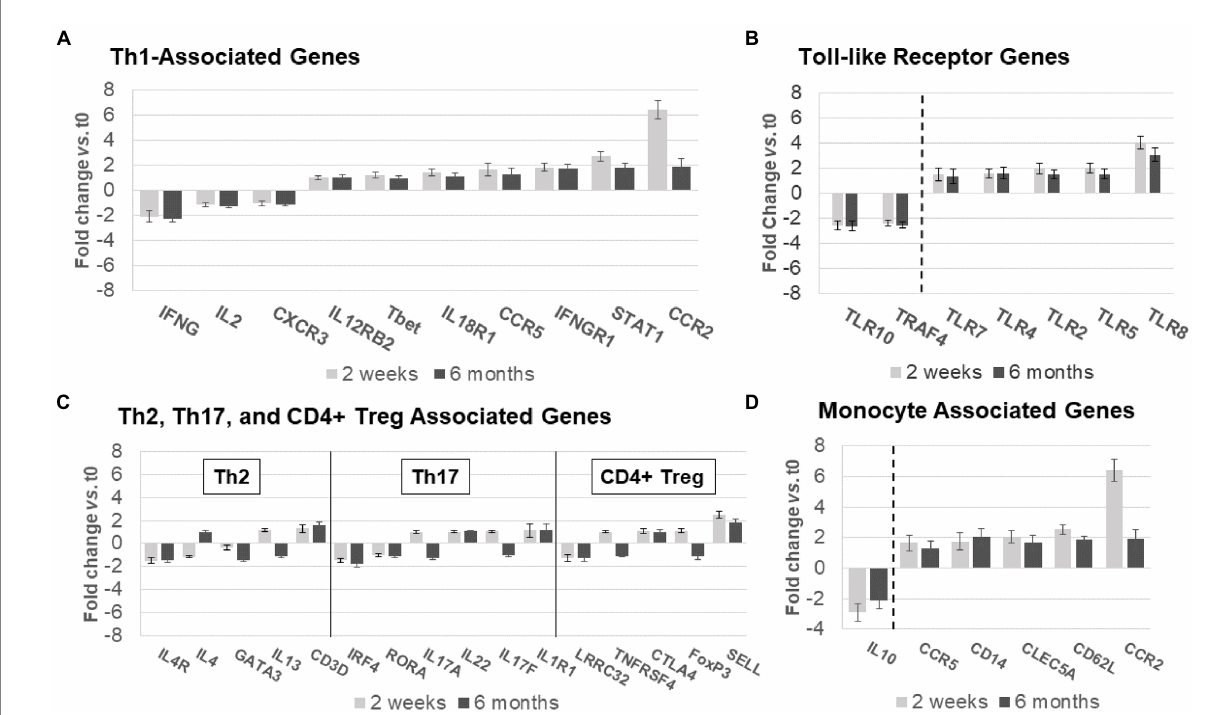
FIGURE 6 Expression of non-B-cell-related genes in MS PBMC at time 0, 2 weeks, and 6 months after ocrelizumab infusion. (A) Th1-associated gene expression is predominantly increased. IFN- γ , CCR5, IFN γ R1, STAT1, and CCR2 have fold-change > |1.5|. (B) Th2, Th17, and CD4+ Treg-associated genes show minimal change. Only 3 have fold-change > |1.5| and none> |2|. (C) Toll-like receptor associated genes show strong upregulation in expression of pro- inflammatory genes, and downregulation of anti-inflammatory TLR10 and TRAF4 . All have fold-change > |1.5|. (D) Monocyte-associated genes also show strong upregulation, paired with decrease in expression of anti-inflammatory IL10 . All have fold-change > |1.5|. Genes shown are those with greatest change in expression for each immune subset. Gene expression 2 weeks (light gray) and 6 months (dark gray) after ocrelizumab infusion vs. time 0. Deconvolution analysis of subsets is described in Methods. Bars show mean ±